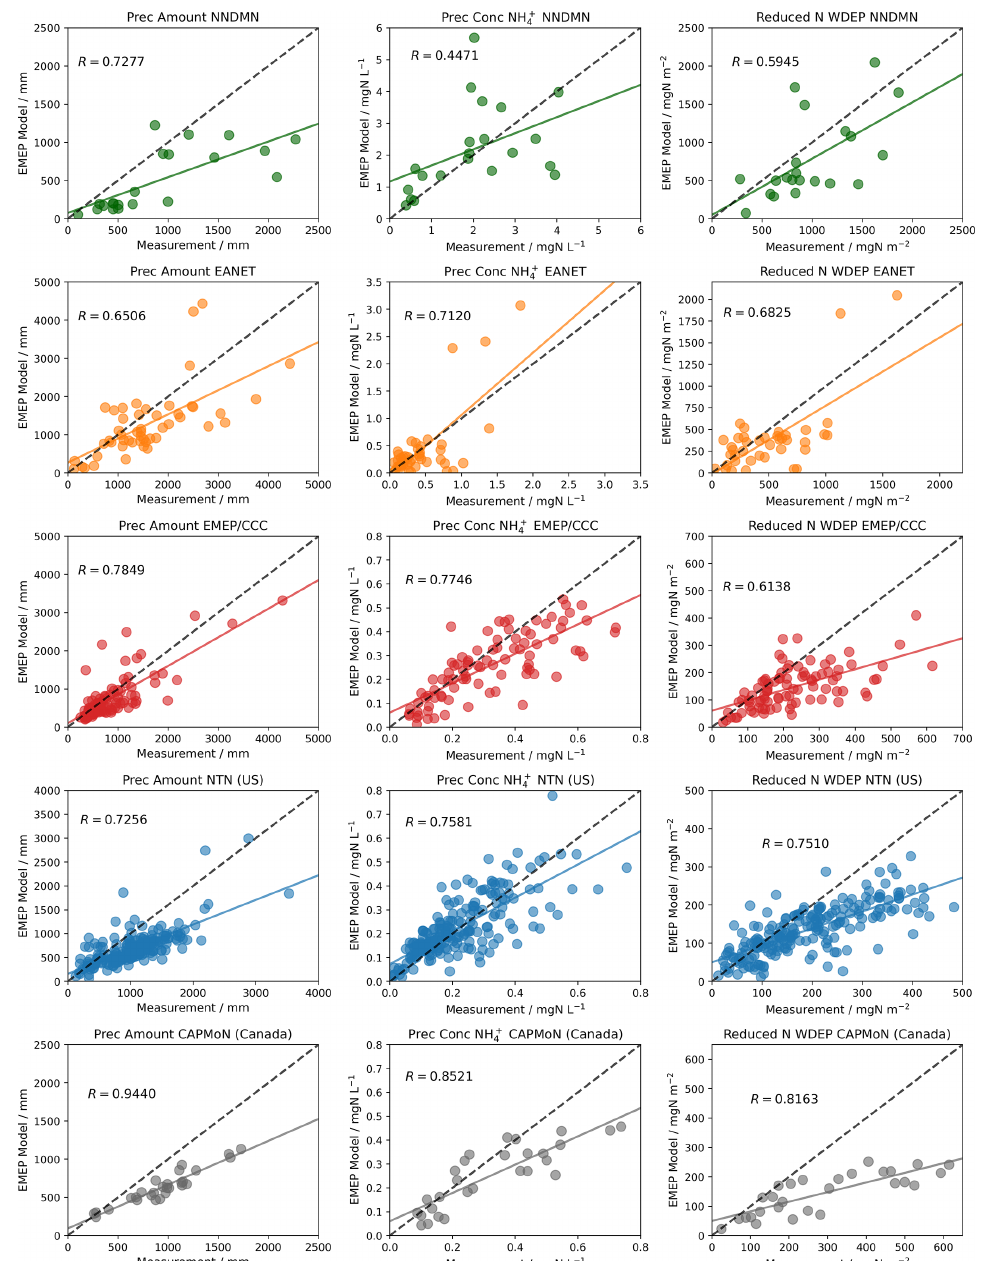
Figure 12. Scatter plots of model–measurement comparisons of 2015 annual wet deposition variables for reduced N (in the form of NH 4 + ) for five measurement networks: NNDMN, EANET, EMEP/CCC, US NTN, and Canada CAPMoN. The left column shows annual precipita- tion. The middle column shows precipitation-weighted annual average NH 4 + concentration in precipitation. The right column shows annual total wet deposition of NH 4 + . In each plot, the coloured line is the least-squares regression, and the dashed black line is the 1 : 1